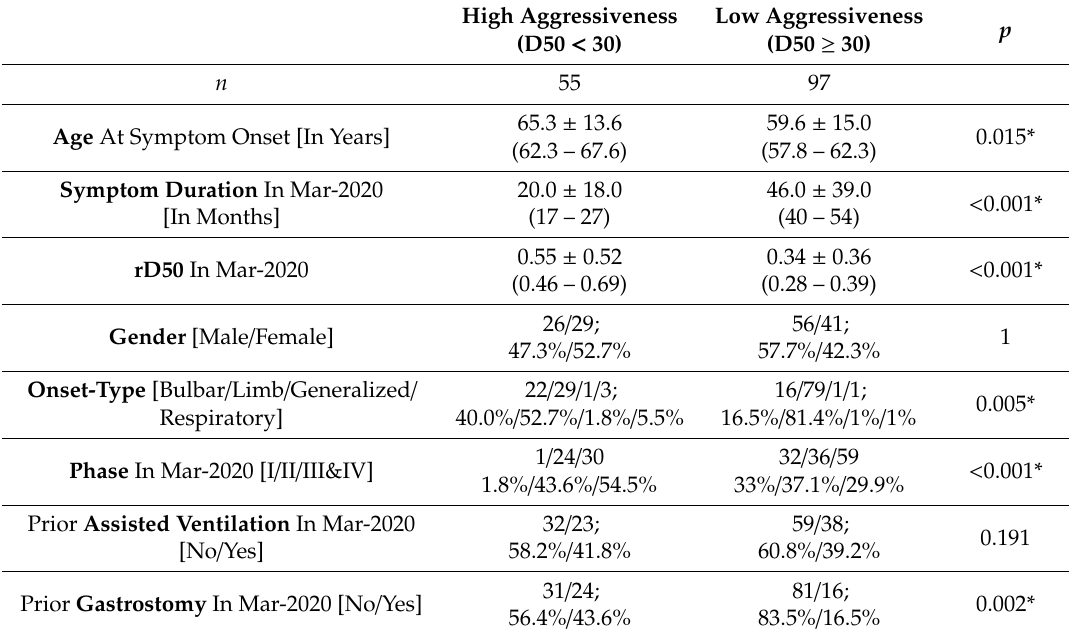
Table 1. Demographic and Clinical Data for alive patients of the prospective cohort, stratified by D50. High